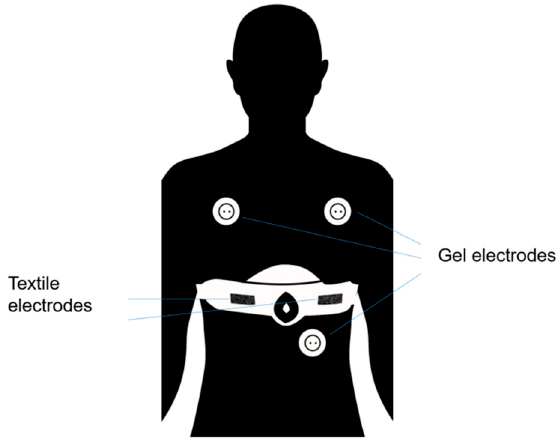
Figure 1. Placement of the gel electrodes and the ECG-belt. Table 1. Baseline characteristics of patients with suspected sleep apnoea.